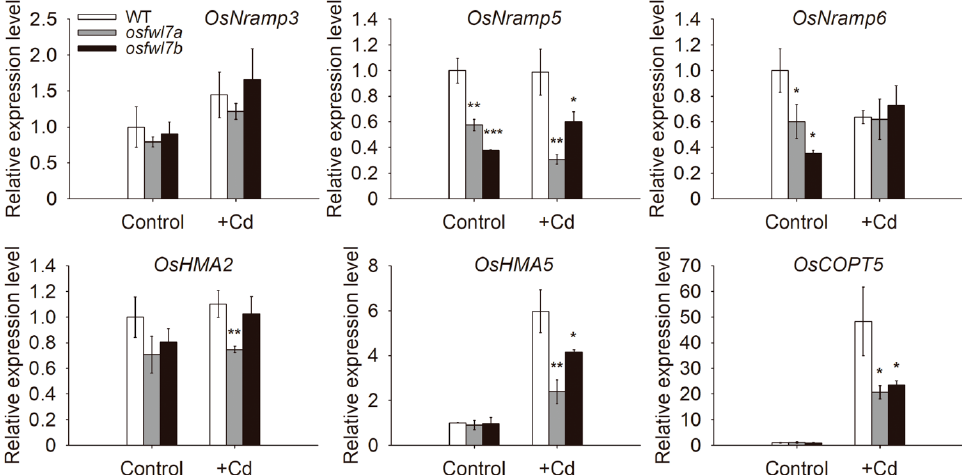
Figure 5. Expression patterns of heavy metal transporter genes in the wildtype (WT) and osfwl7 mutants determined using RT-qPCR. The genes assayed were as follows: OsNramp3 ( LOC_Os06g46310 ), OsNramp5 ( LOC_Os07g15370 ), OsNramp6 ( LOC_Os01g31870 ), OsHMA2 ( AB697186 ), OsHMA5 ( LOC_Os04g46940 ), and OsCOPT5 ( LOC_Os05g35050 ). The rice Actin1 gene was used for normalization of gene expression. Error bars indicate the standard deviation of three biological replicates. * p < 0.05, ** p < 0.01, *** p < 0.001.